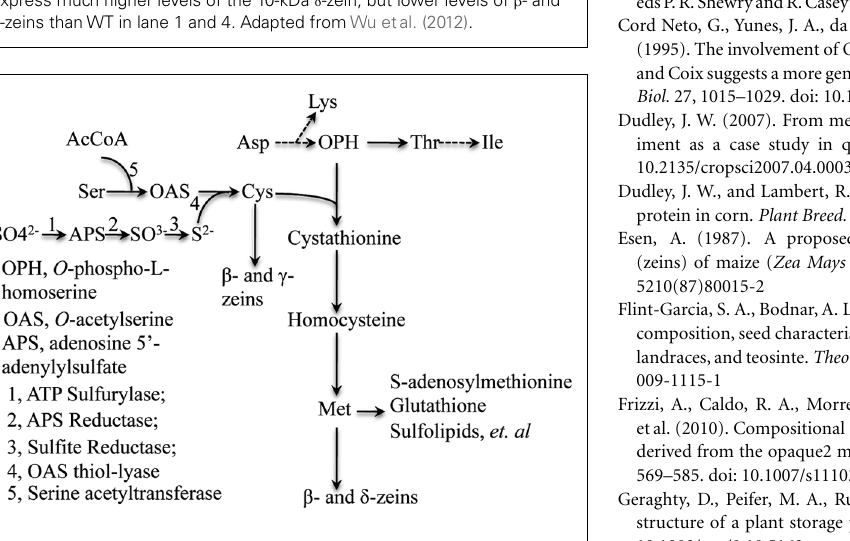
FIGURE 4 | Sulfate reduction and synthesis of cysteine and methionine pathways. The flow of sulfur is shown to illustrate sink source relationship. Adapted fromWu etal.